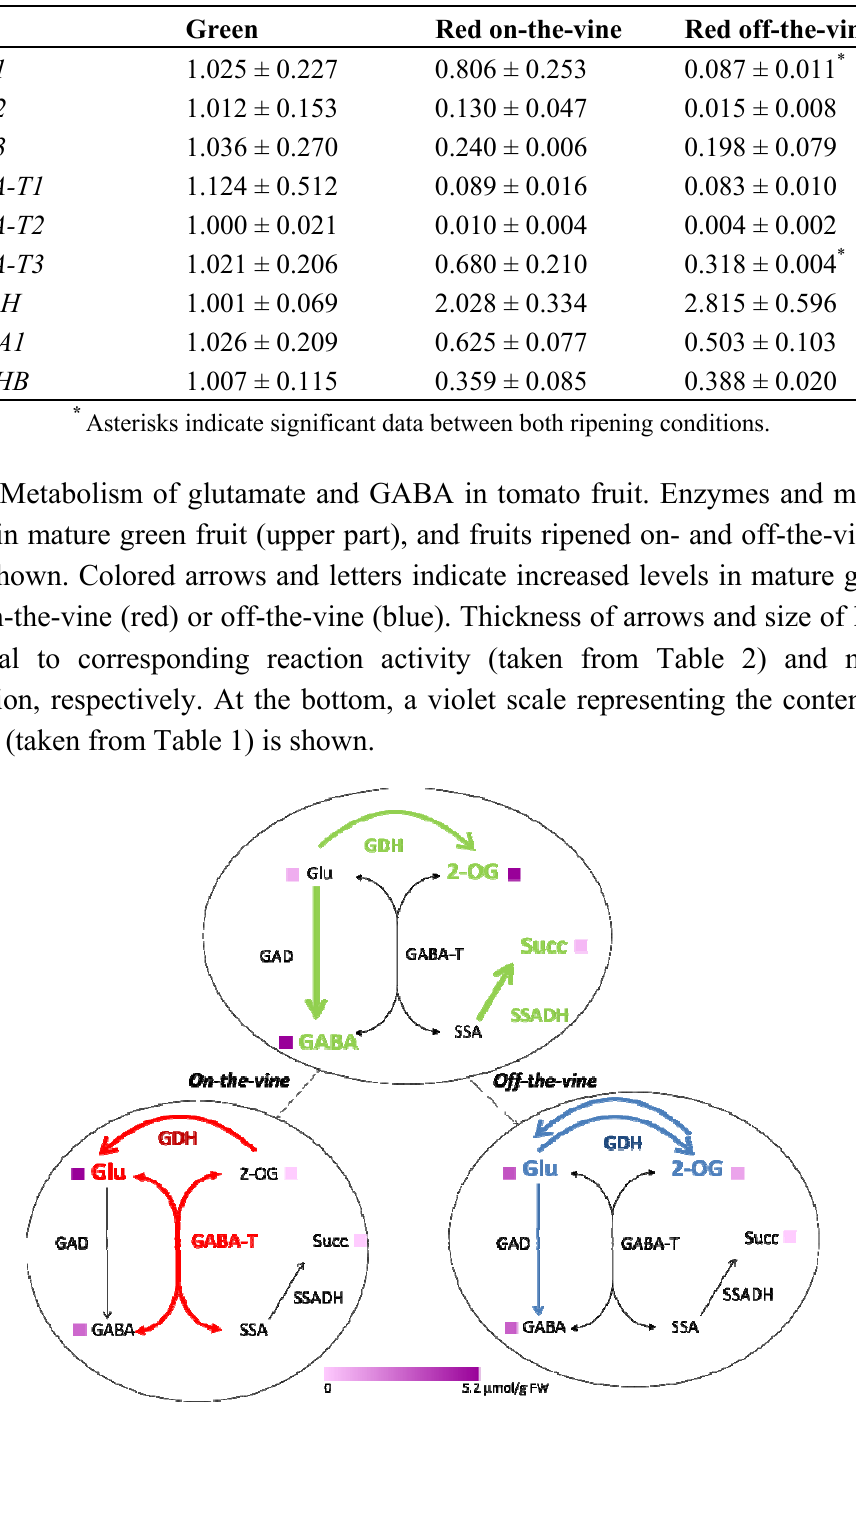
stage and red ripened on- and off-the-vine for transcript profile analysis by qRT-PCR. Transcript levels are relative to those in mature green fruit. Results are the means of three by Holm Sidak test analysis ( p < 0.05).